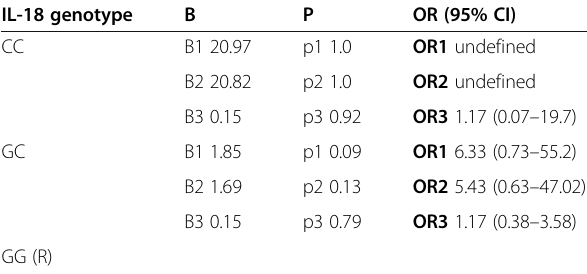
Table 7 Binary logistic regression for prediction of HCC in the studied